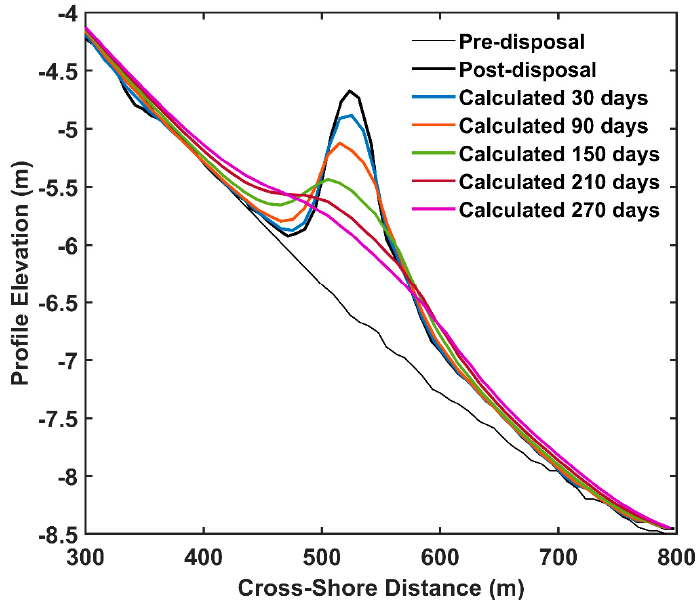
Figure 4. The evolution of the mound with time.